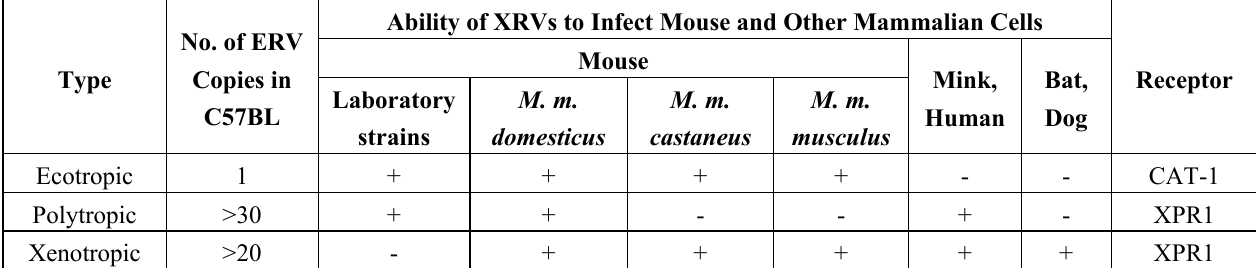
Table 1. Host range variants of mouse leukemia viruses isolated from laboratory